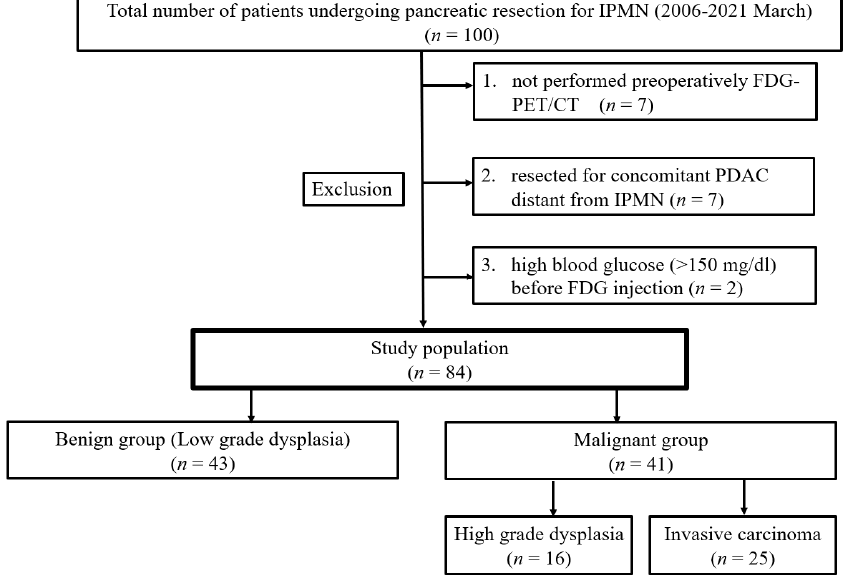
Figure 1. Distribution of the patients with IPMN. IPMN: intraductal papillary mucinous neoplasm; FDG: 18 F-fluorodeoxyglucose.